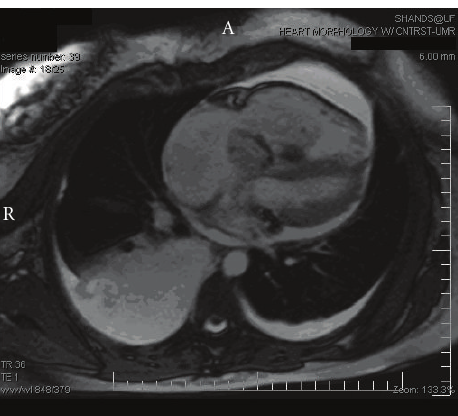
Figure 3: Post-gadolinium infusion delayed enhancement study re- veals significant uptake of gadolinium consistent with edema, fibro- sis or